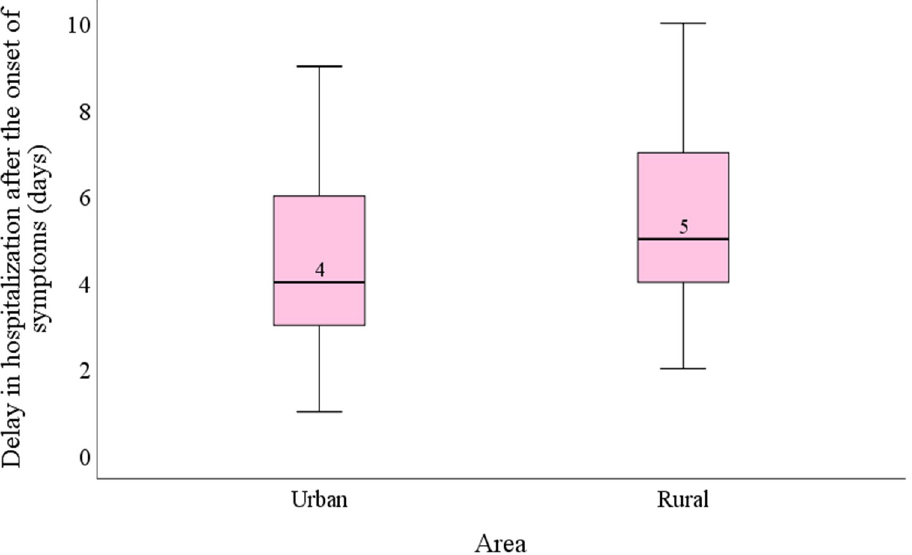
Fig 5. Relationship between the area of residence of the patients and delay in hospitalization after the onset of symptoms.